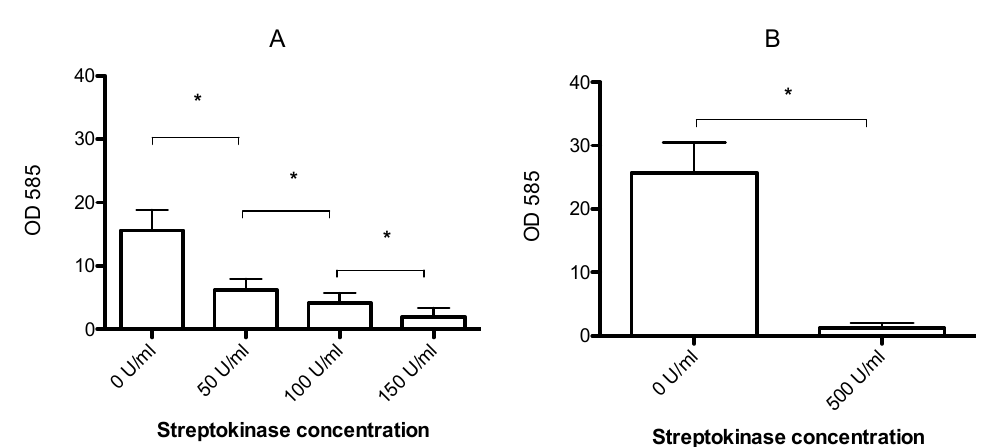
Figure 2. Mean biofilm biomass ( ± SD, n = 8), measured by crystal violet staining after incubation of 2 h old ( A ) and 24 h old ( B ) biofilms with streptokinase for 24 h. Increasing concentrations of streptokinase resulted in a dose dependent decrease in biomass. A single high dose was applied to 24 h old biofilms, resulting in almost complete biofilm dispersal. * significantly different ( p < 0.001).